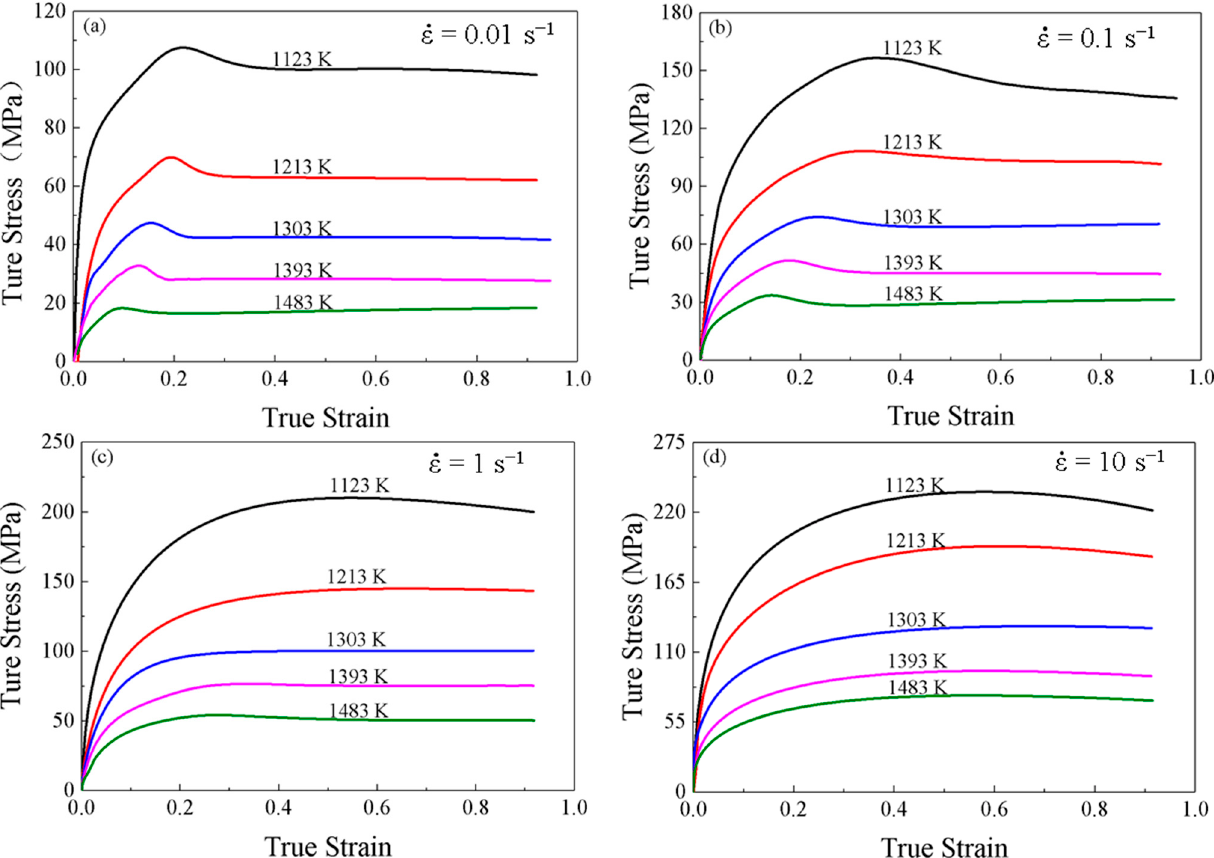
Figure 5. True strain-stress curves for SAE 5137H steel under different deformation temperatures and strain rates of ( a ) 0.01 s − 1 , ( b ) 0.1 s − 1 , ( c ) 1 s − 1 and ( d ) 10 s − 1 .